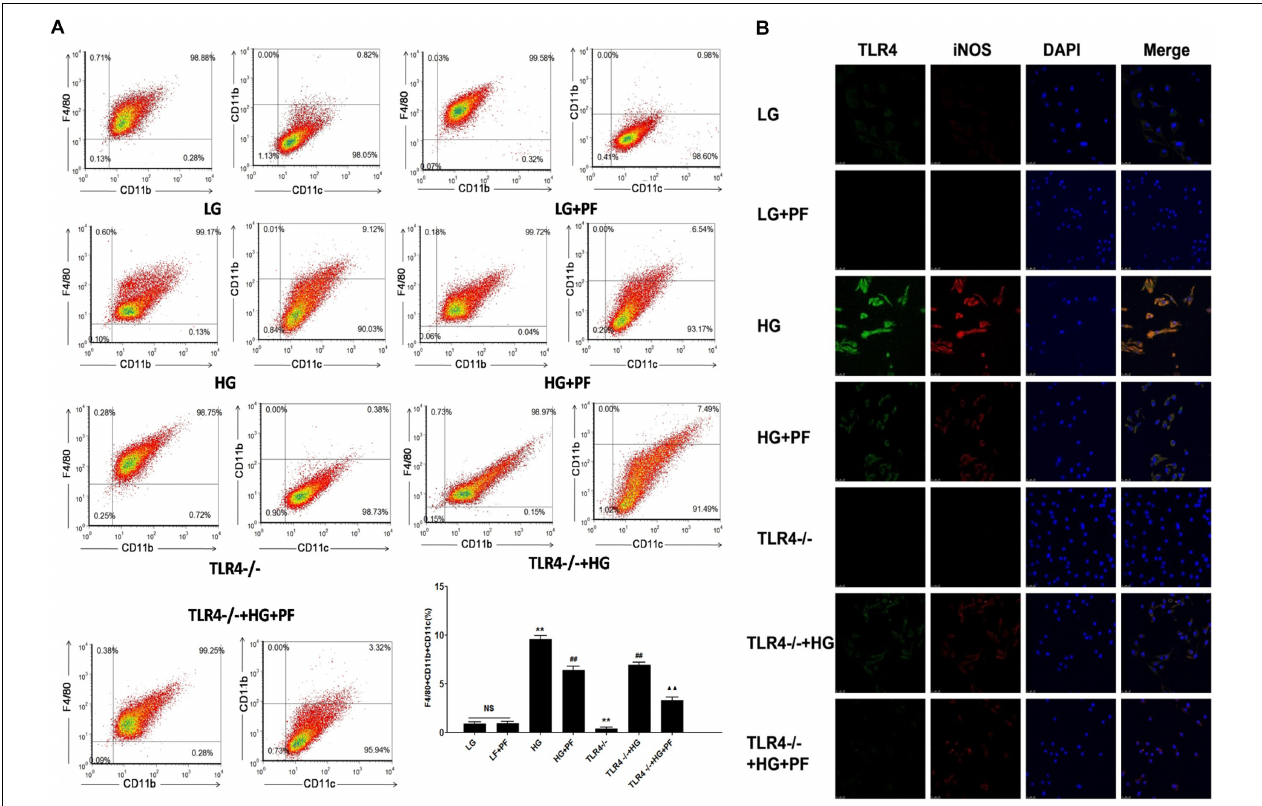
FIGURE 5 | PF decreased HG-induced BMDM differentiation toward a proinflammatory phenotype. (A) BMDM activation analysis showing the effects of PF on the expression of macrophage surface markers in HG-induced BMDMs. F4/80 and CD11b are surface markers of macrophages, and CD11c is considered a marker of M1-type macrophages. The markers were assessed by flow cytometry. The results are expressed as the mean ± SD of at least three independent experiments. ∗∗ P < 0.01 vs. the LG group; ## P < 0.01 vs. the HG group; (cid:78)(cid:78) P < 0.01 vs. the TLR4-/- + HG group; NS: not significant. (B) The coexpression of TLR4 and iNOS in HG-induced BMDMs assessed by confocal microscopy. The effects of PF on the expression of TLR4 signaling pathway molecules and activation of macrophages in HG-induced BMDMs were evaluated by confocal microscopy